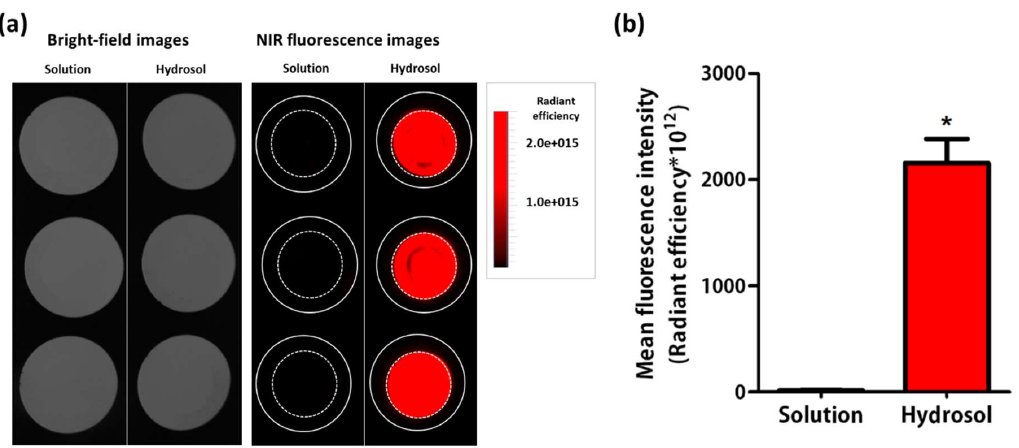
Figure 6. In vitro artificial skin deposition of the fluorescent dye-tagged AdP: ( a ) NIR image of STM membranes and ( b ) their mean fluorescence intensity values after 8 h of incubation are shown. The dashed circle means the effective surface area (1.76 cm 2 ) of the Keshary-Chien cell. Data are presented as the mean ± SD ( n = 3). * p < 0.05, significantly different from each other.